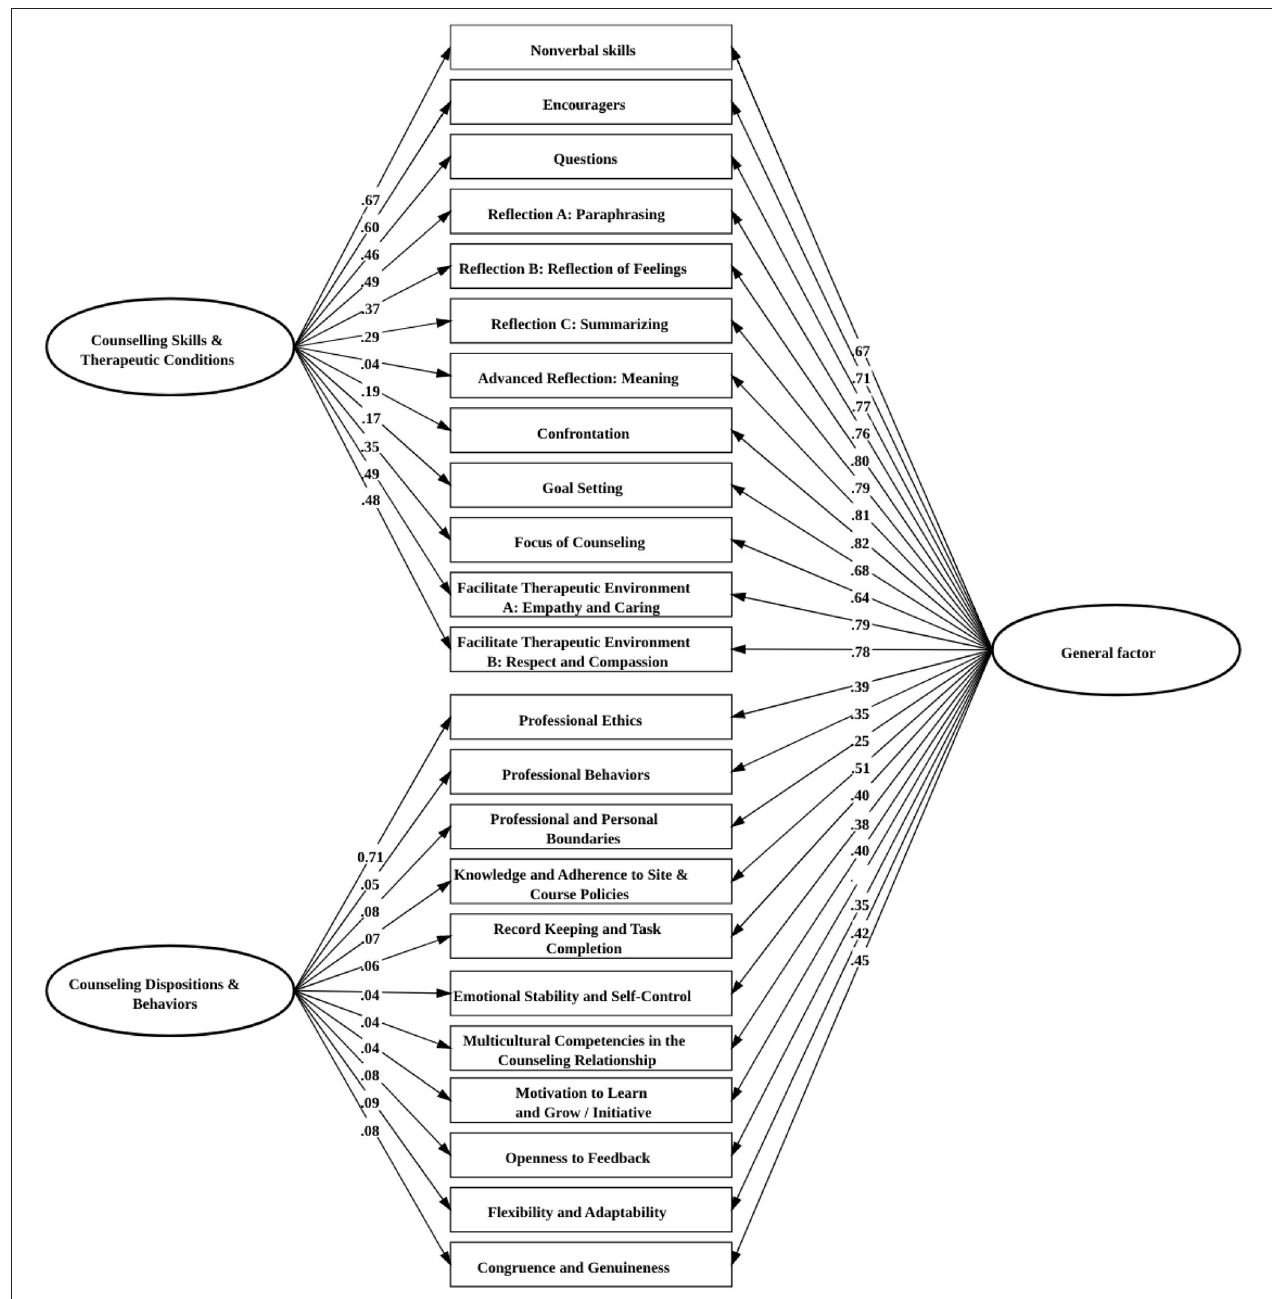
FIGURE 3 | CCS-R bifactor model confirmatory analysis